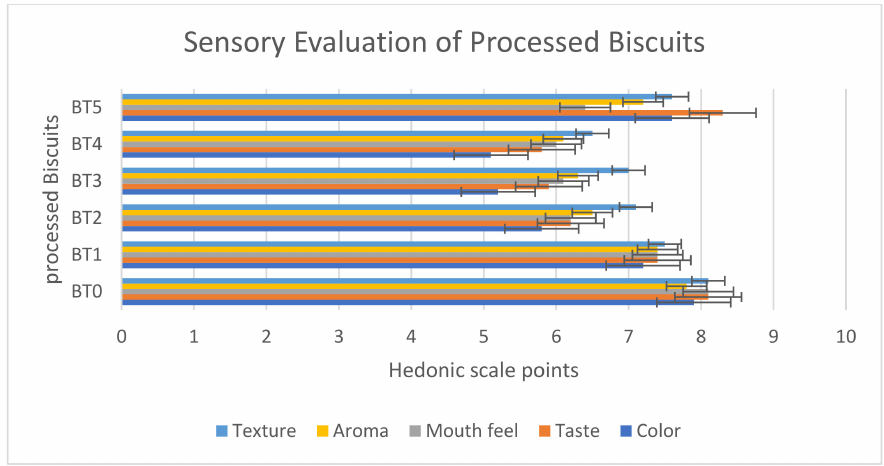
Figure 6. Sensory evaluation of processed biscuits.